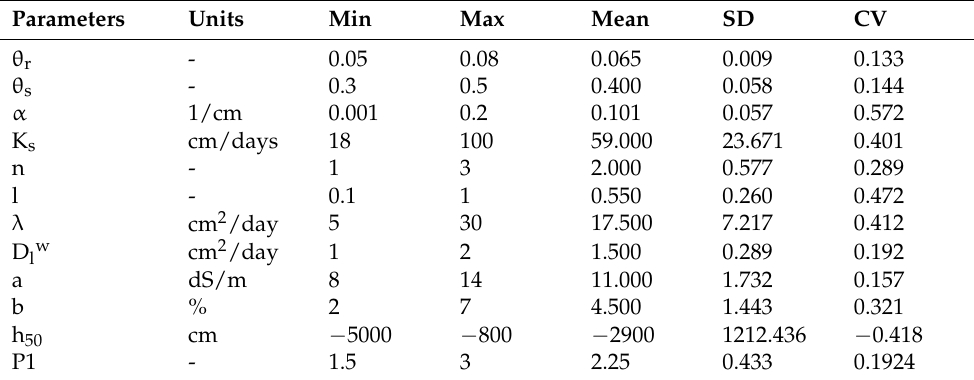
Table 5. The prior distribution of the parameters used in